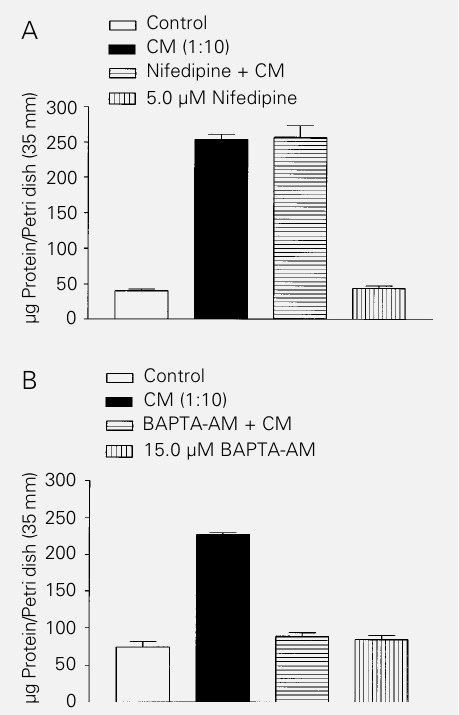
Figure 2 - Histograms showing the protein content of retinal cul- tures. A , The cells were incu- bated for 120 h with control me- dium (control), conditioned me- dium (CM; 1:10), 5.0 µM nifedi- pine or nifedipine + CM. B , The cells were incubated for 96 h with control medium (control), conditioned medium (CM; 1:10), 15.0 µM BAPTA-AM or BAPTA- AM + CM. Data are reported as the mean ± SEM of 3 independ- ent experiments, each per- formed in